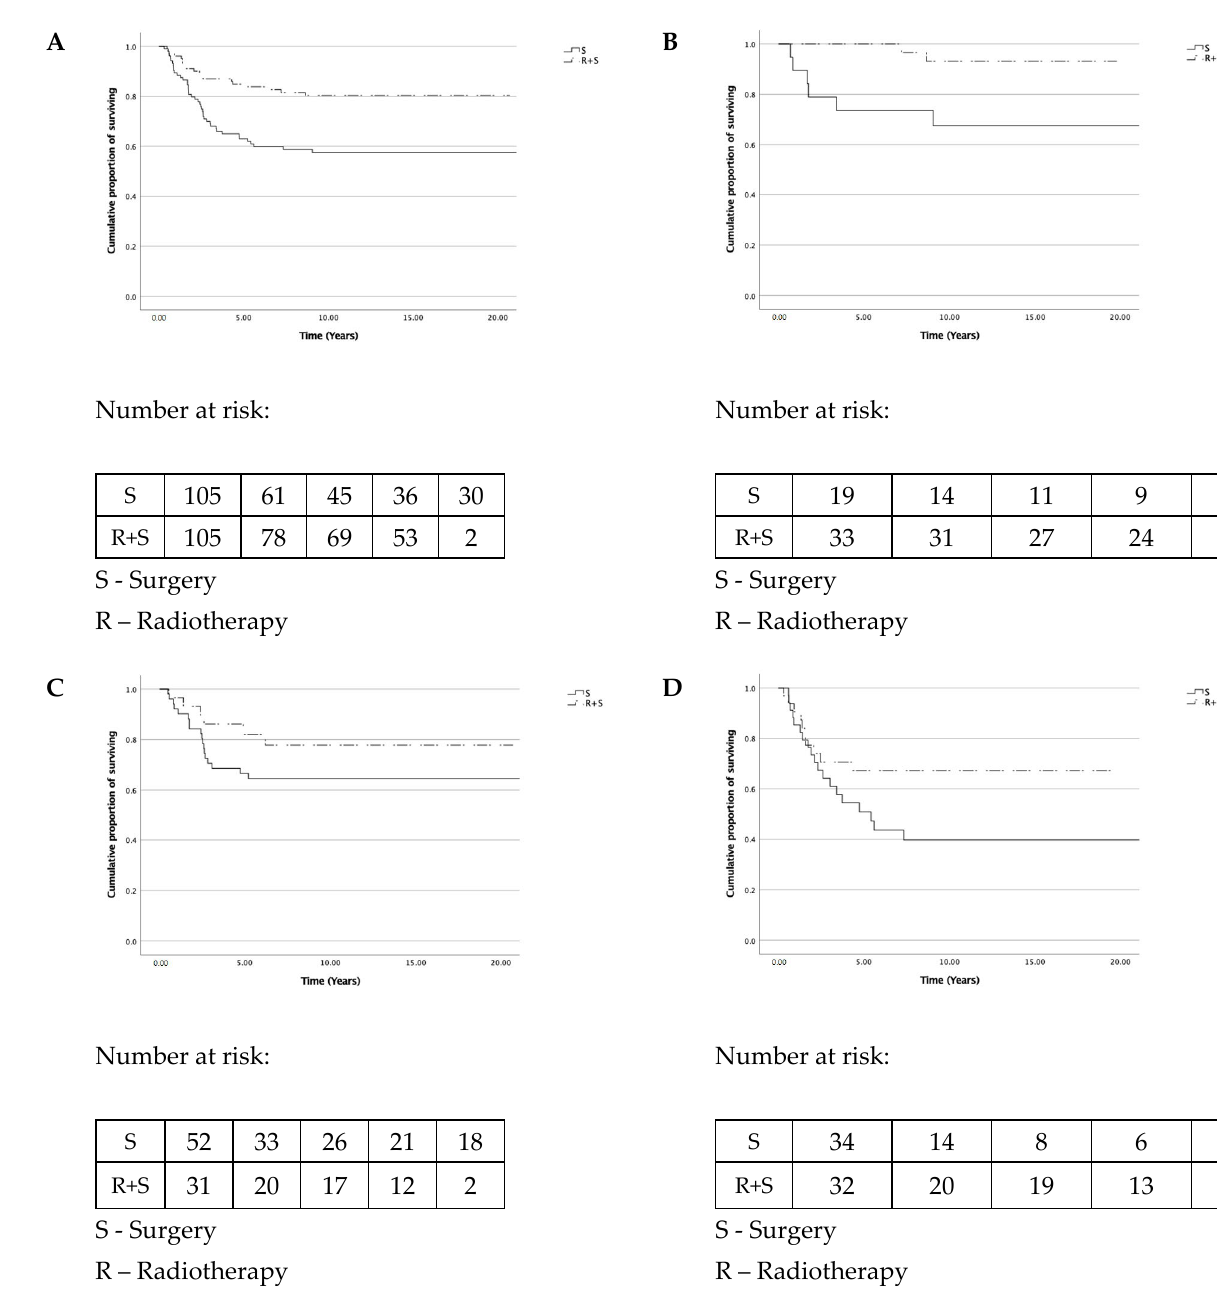
9 of 13 Figure 2. Overall survival. ( A ) For all patients, log-rank p = 0.107. ( B ) For stage (y)pI patients, log-rank p = 0.513. ( C )For stage (y)pII patients, log-rank p = 0.616. ( D ) For stage (y)pIII patients, log-rank p = 0.094. 3.3. Recurrence-Free Survival